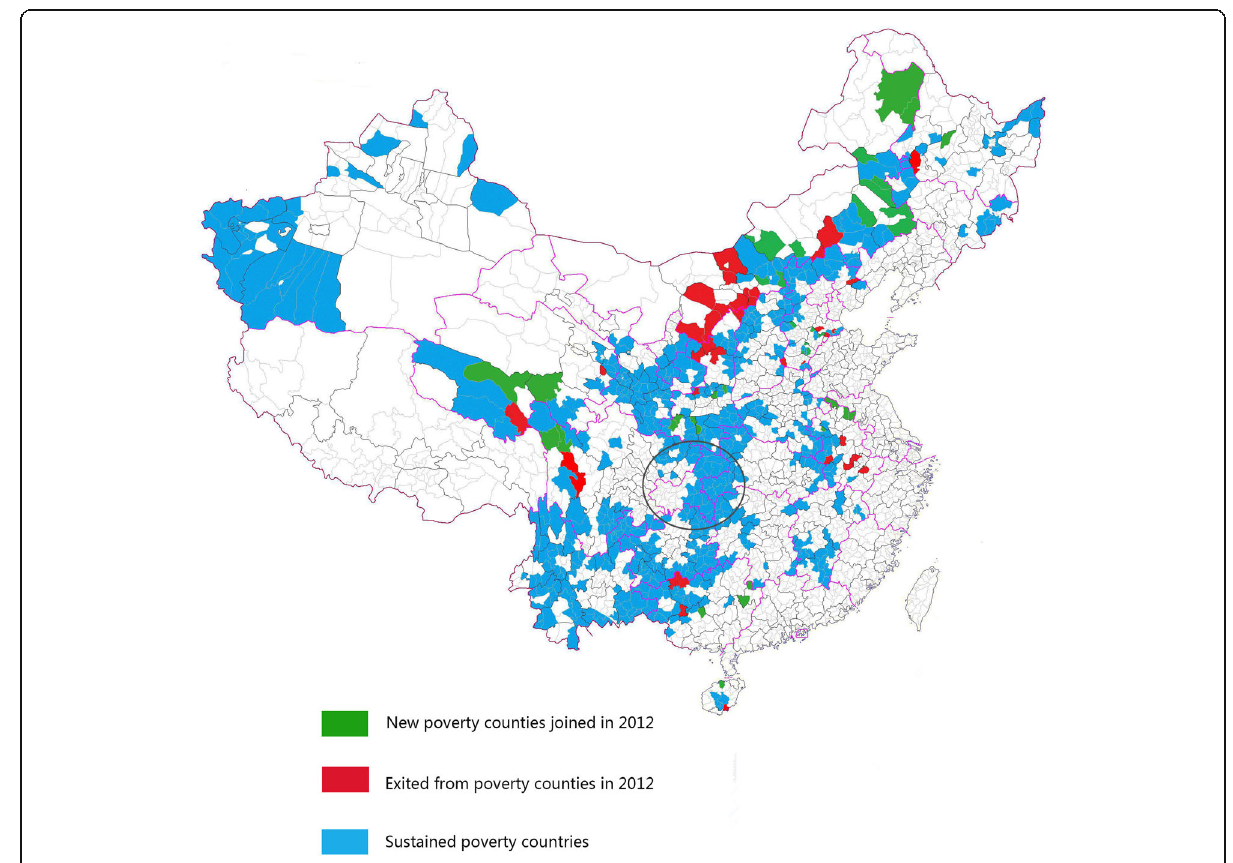
Fig. 1 Location distribution of poverty state counties in China (the map is not fully